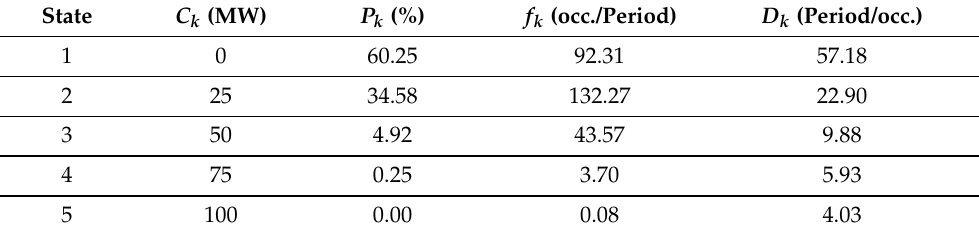
Table 6. Capacity outage probability table—scenario